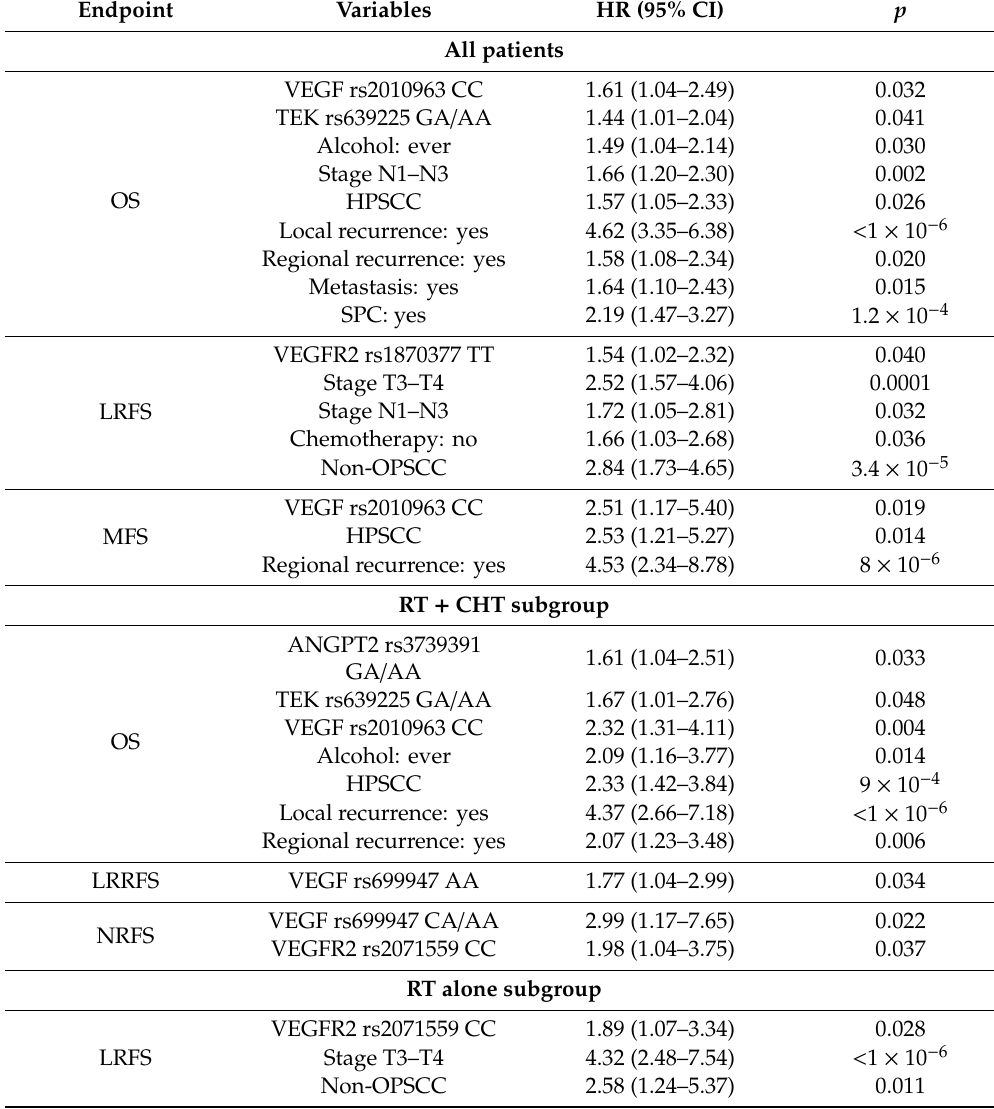
Table 4. Stepwise multiple regression analysis for the e ff ect of SNPs on OS, LRFS, and MFS in the whole group, for OS, LRRFS, and NRFS in the combination treatment subgroup (RT + CHT), and for LRFS in the RT alone